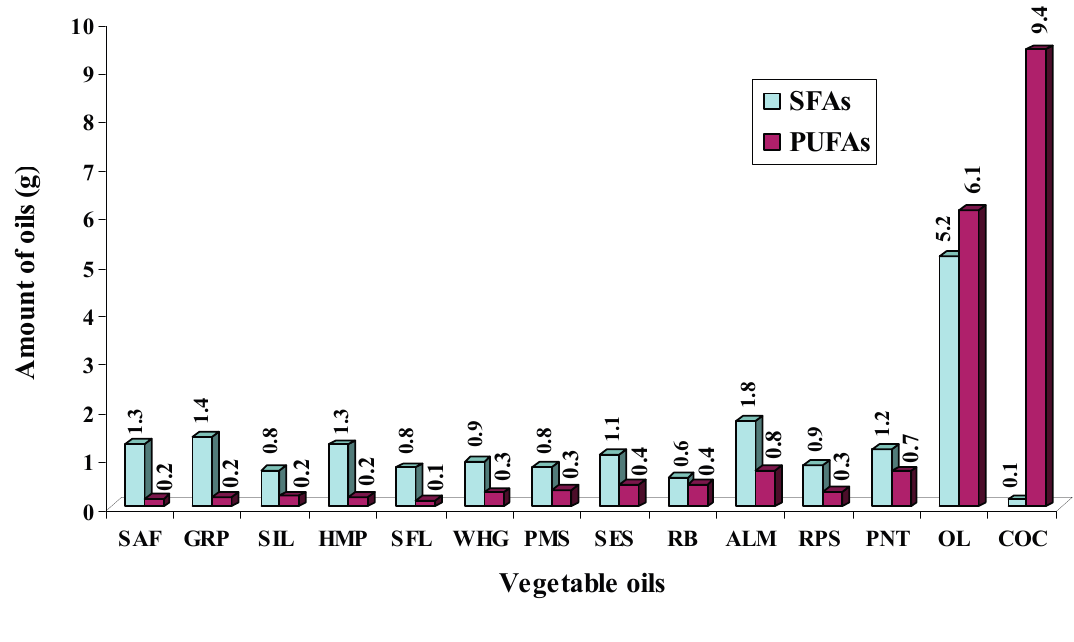
Figure 1. Oil amounts (g) needed to cover recommended energy daily intakes of SFAs and PUFAs calculated from their maximal recommended daily values (E RDI ).